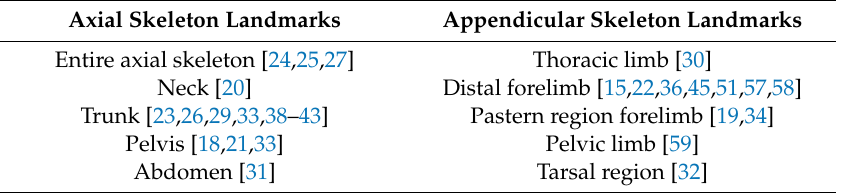
Table 3. Reported anatomical regions assessed with pressure